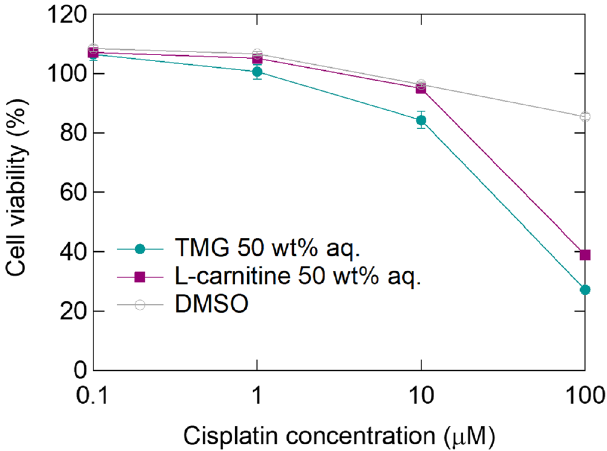
Figure 1. MDA-MB-231 cell viability after treatment with cisplatin dissolved in the indicated solvents. (n = 3, biologically triplicated).